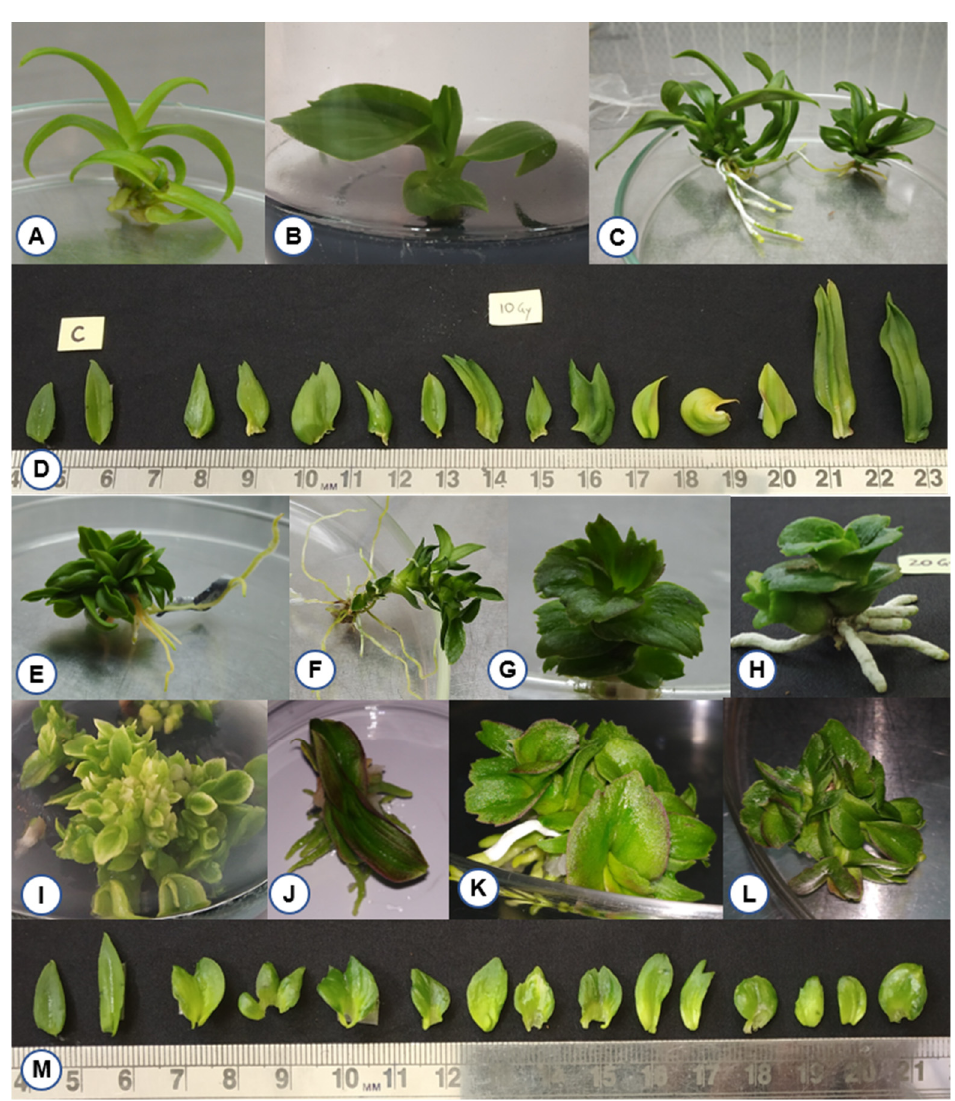
Figure 4. Morphological variations among in vitro plantlets regenerated from gamma-irradiated protocorm-like bodies (PLBs) of Dendrobium ‘Emma White’. PLBs of Dendrobium ‘Emma White’ were irradiated with gamma ray doses of 10, 20, 40, 60 and 80 Gy and incubated at 22 ± 2 °C and 65–70% relative humidity with 16 h photoperiod. Seven to eight months post irradiation, alterations in growth and structure of shooting pattern were observed at 10, 20 and 40 Gy doses. ( A ) Control unirradiated plantlet, ( B – D ) leaf variations at 10 Gy, ( E – H ) leaf variations at 20 Gy, ( I – M ) Leaf variations at 40 Gy. Morphological variation observed in leaf distribution pattern ( B , C , E ); leaf margin, midrib, apex, shape, and color ( D , M ); leaf margin ( G , J , K , L ); leaf color ( I ); leaf texture ( H ); multiple shoots formation ( F ).